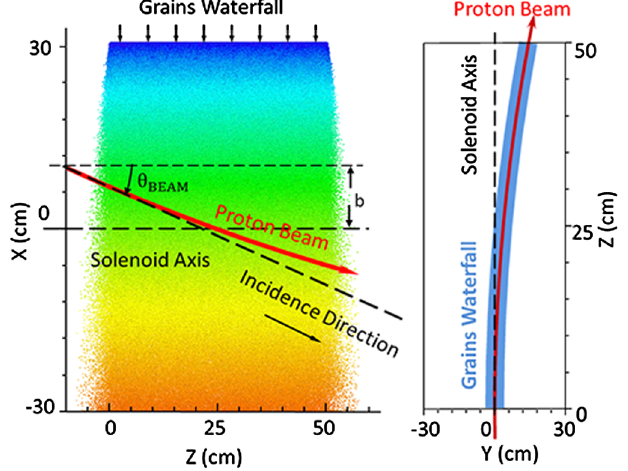
FIG. 15. The beam-target geometry for the waterfall target.